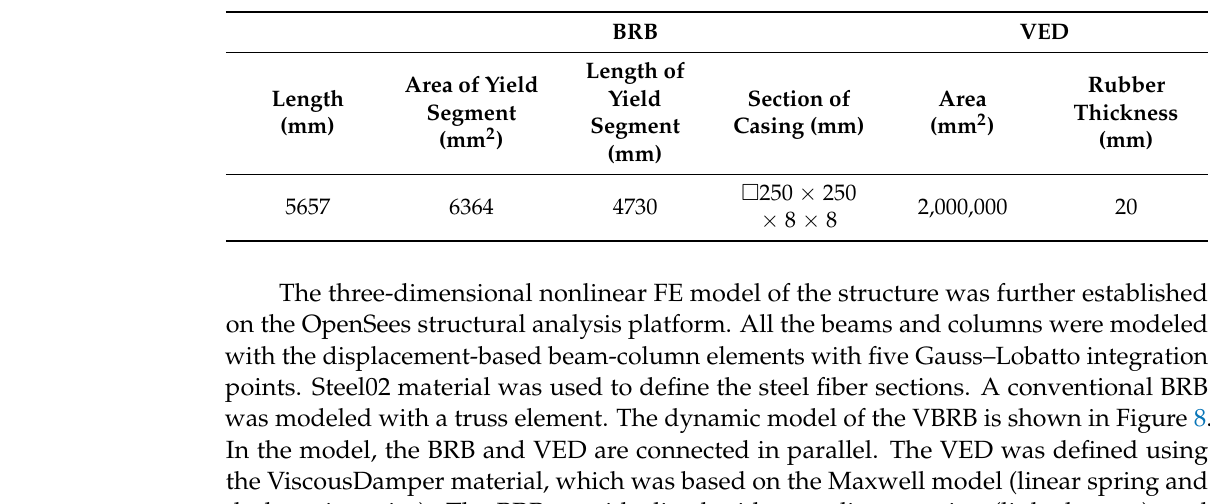
Table 7. Geometric parameters of the selected BRB brace and